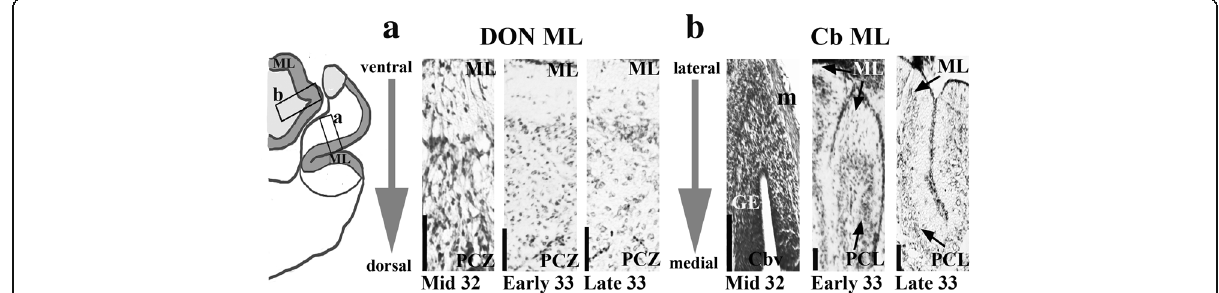
Fig. 5 Light micrographs of cerebellar and cerebellar-like cross sections in Leucoraja erinacea , showing earlier ML development in the cerebellum- like structures than the Cb. Anatomical drawing illustrates the location of images in a and b. ML and PCZ in the DON at mid-stage 32, early stage 33 and late stage 33 ( a ). Sections are oriented ventral (ML) to dorsal (PCZ). Cb showing the ML and PCL at the same stages ( b ). Sections are oriented lateral (ML) to medial (GE). Scale bars equal 100 μ m. Abbreviations: Cb , cerebellum; Cbv , cerebellar ventricle; DON , dorsal octavolateralis